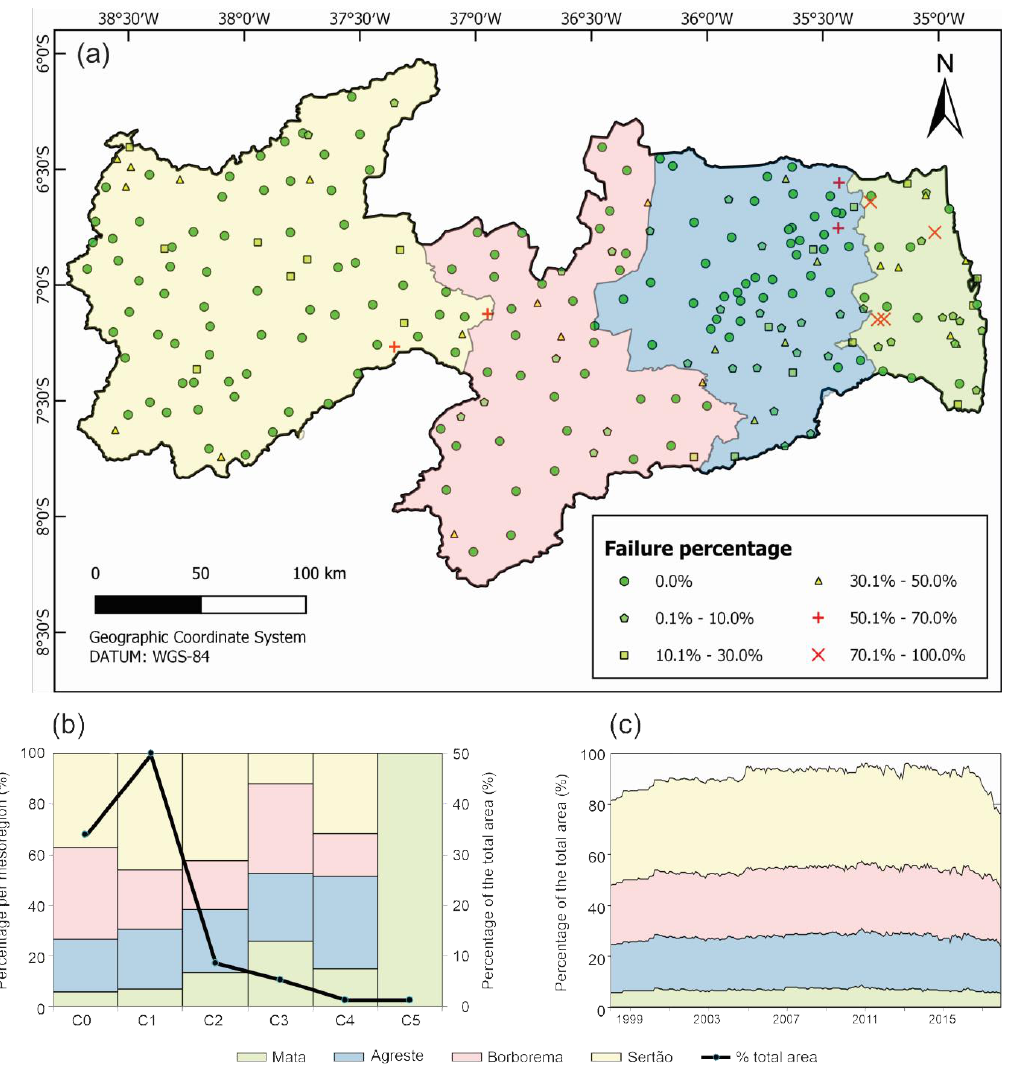
Figure 4. ( a ) Spatial distribution of the missing data percentages in the rainfall time series; ( b ) percentage distribution of the missing data for each mesoregion; and ( c ) temporal evolution of the percentage of data available over the 20 years.